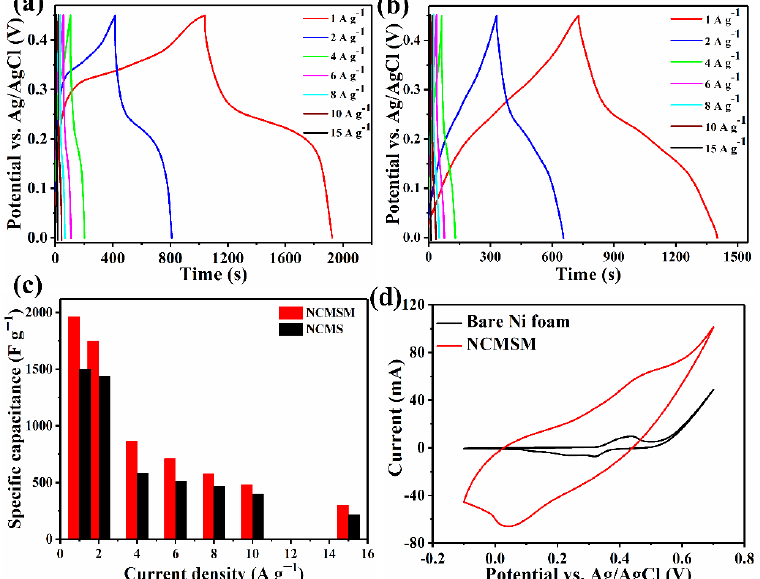
Figure 9. Galvanostatic charge-discharge curves of ( a ) NCMSM and ( b ) NCMS at different current densities within the potential window 0 to 0.45 V; ( c ) the histogram of C s vs. current density for NCMS and NCMSM; and ( d ) the CV curves of NCMSM and bare Ni foam at a scan rate of 20 mV s − 1 ; all in 1M KOH.